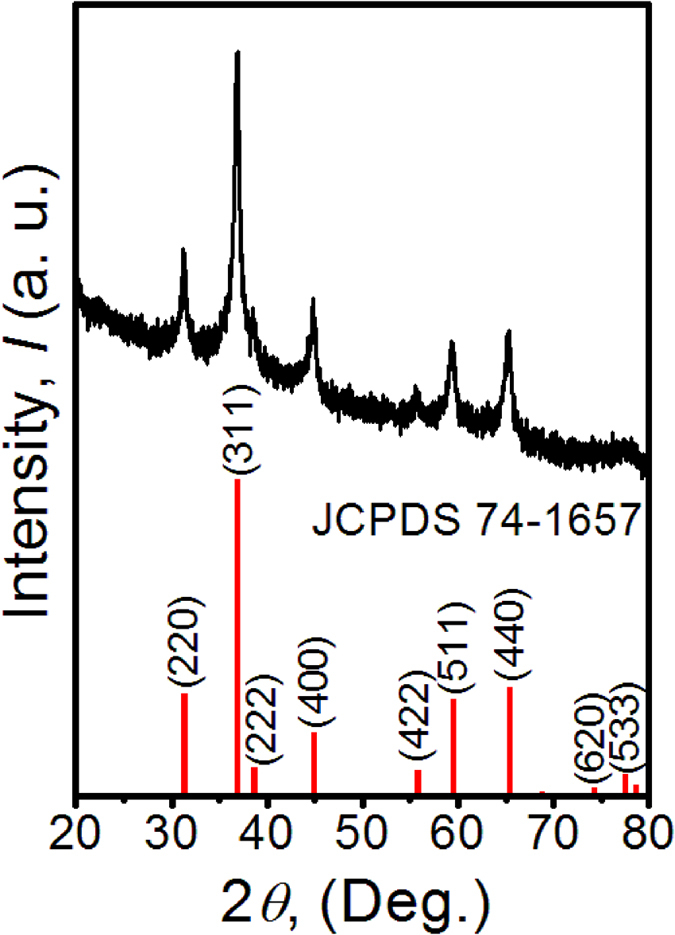
XRD pattern of as-prepared sample and the standard pattern of Co3O4 phase.